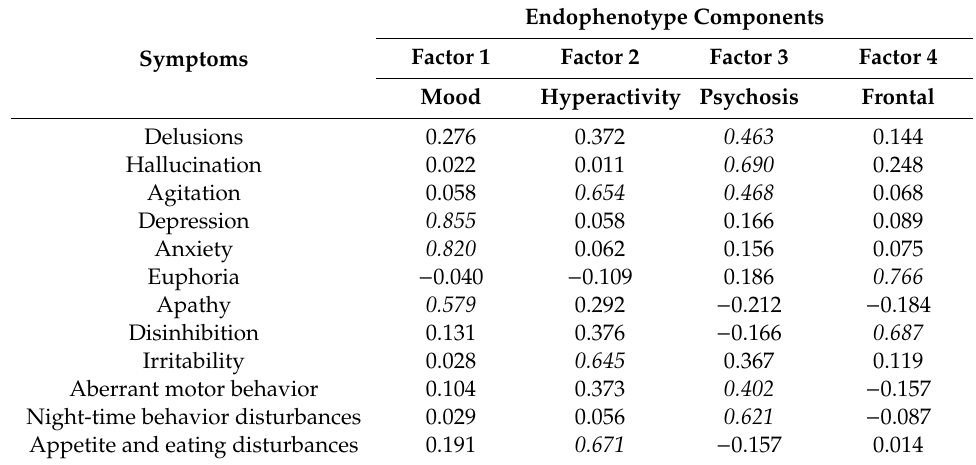
Table 4. Principal component analysis (PCA) of the Behavioral and Psychological Symptoms of Dementia (BPSD) in our Italian Alzheimer’s Disease cohort.